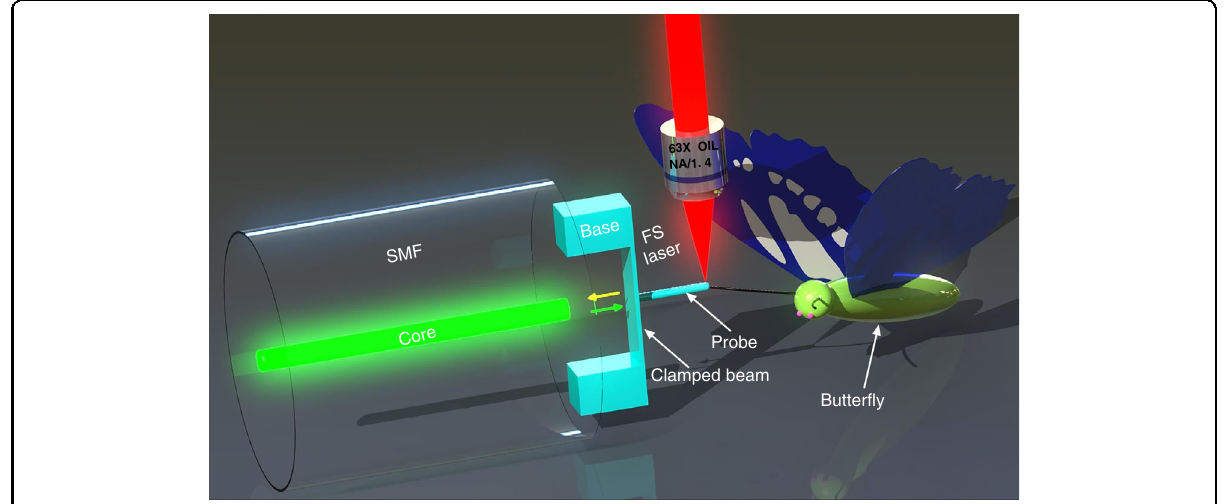
Fig. 1 Schematic of the sensor. Schematic diagram of all- fi ber micro-force sensor based on a polymer clamped-beam